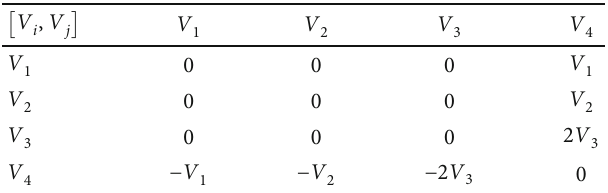
Table 1: Commutator table.